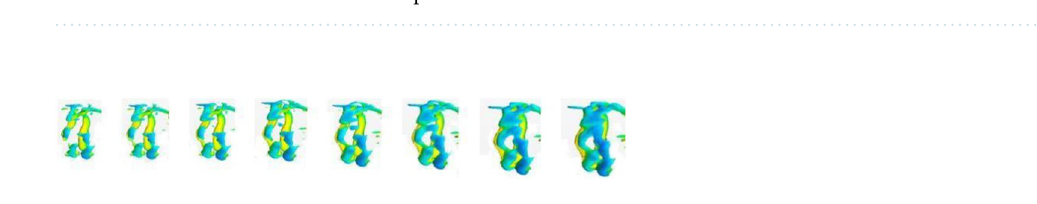
Figure 27. Development of double ring structure from t 1 to t 2 ( Δ t = 0.01 s).